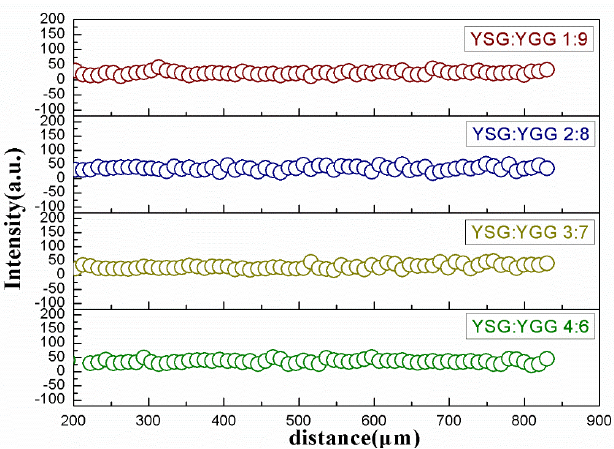
Figure 3. The Er 3+ EPMA patterns of different proportions of YSG:YGG from 1:9 to 4:6.